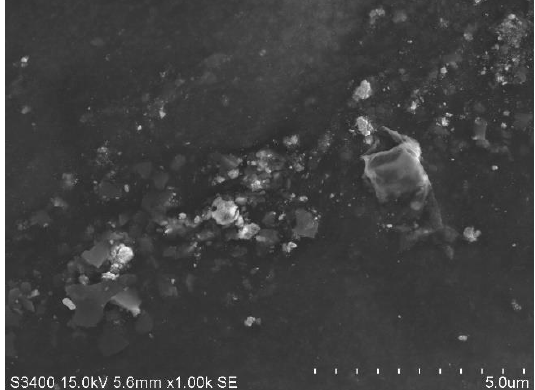
Figure 5. SEM image of